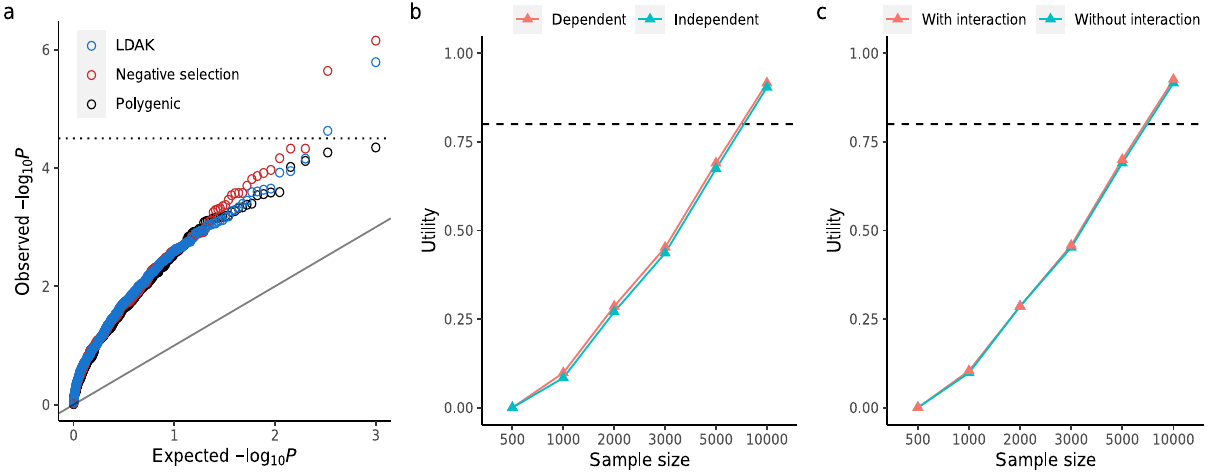
Fig. 5 The PB-LEV correlation under different genetic architectures. a We compared the signi fi cance of the correlation between the polygenic burden (PB) and large-effect variant (LEV) in cases for three classes of genetic architecture, namely, “ polygenic ” , “ negative selection ” , and “ LDAK ” (see Methods). The expected – log( P ) and the observed – log( P ) from 500 simulations are shown on x-axis and y-axis, respectively. In the case of relatively modest PB heritability ( h 2 ¼ 0 : 1), higher-signi fi cance levels (i.e., lower p values) were observed for “ negative selection ” and the “ LDAK ” model (than for neutral PB “ polygenic ” architecture), both consistent with the “ fl attening ” of heritability across the genome, which has been attributed to the action of negative ; f ; and K at 0 : 01 ; 0 : 001 ; and 0.01, respectively. Signi fi cance was assessed via Wilcoxon rank-sum test (one-sided). Given the selection. Here, we set h 2 LEV speci fi c combination of simulation parameter values, the dashed horizontal line at 4.5 is a potential threshold that can be used to rule out certain genetic architecture models through comparison of the observed PB-LEV correlation with the framework ’ s predictions. b To test the effect of potentially dependent PB and LEV (in the general population) on the PB-LEV correlation (in cases), we assumed that the LEV was in high LD (D' = 1) with the top-ranked common variant (i.e., with the largest effect size) and compared the utility. Here, we set h 2 ¼ 0 : 3 ; h 2 ¼ 0 : 01 ; f ¼ 0 : 001, and prevalence K ð Þ ¼ 0 : 01, and PB LEV assumed a polygenic genetic architecture and the liability-threshold model in the simulations. c To test the extent to which potential interactions between the PB and LEV could affect the PB-LEV correlation, we assumed that the interaction between the LEV and the common variant with the largest effect size contributed to the variance of the trait ( h 2 ¼ 0 : 02) and performed simulations. All other parameters were fi xed as in ( b ). Broken line at 80% is a interaction reasonable utility threshold. Source data are provided as a Source Data fi